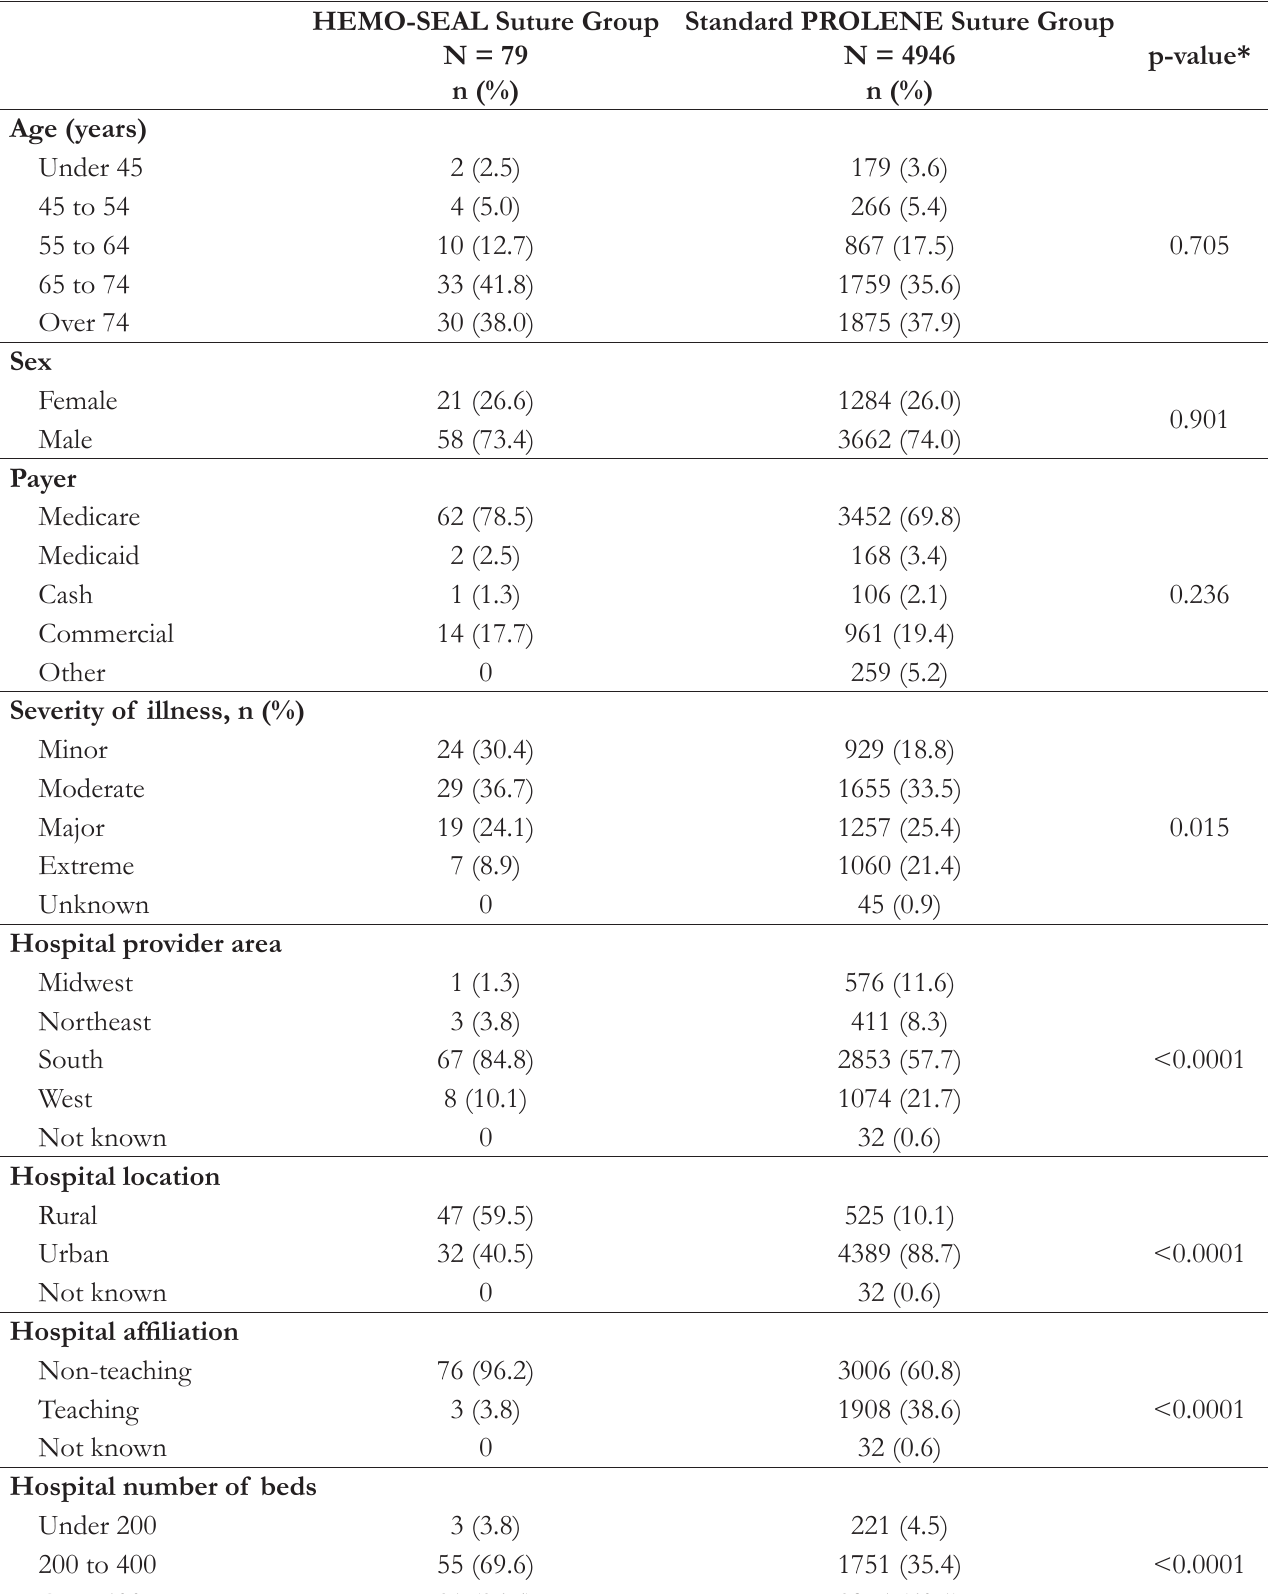
Table 2. Summary of Patient Demographic and Hospital Characteristics by Suture Group HEMO-SEAL Suture Group Standard PROLENE Suture